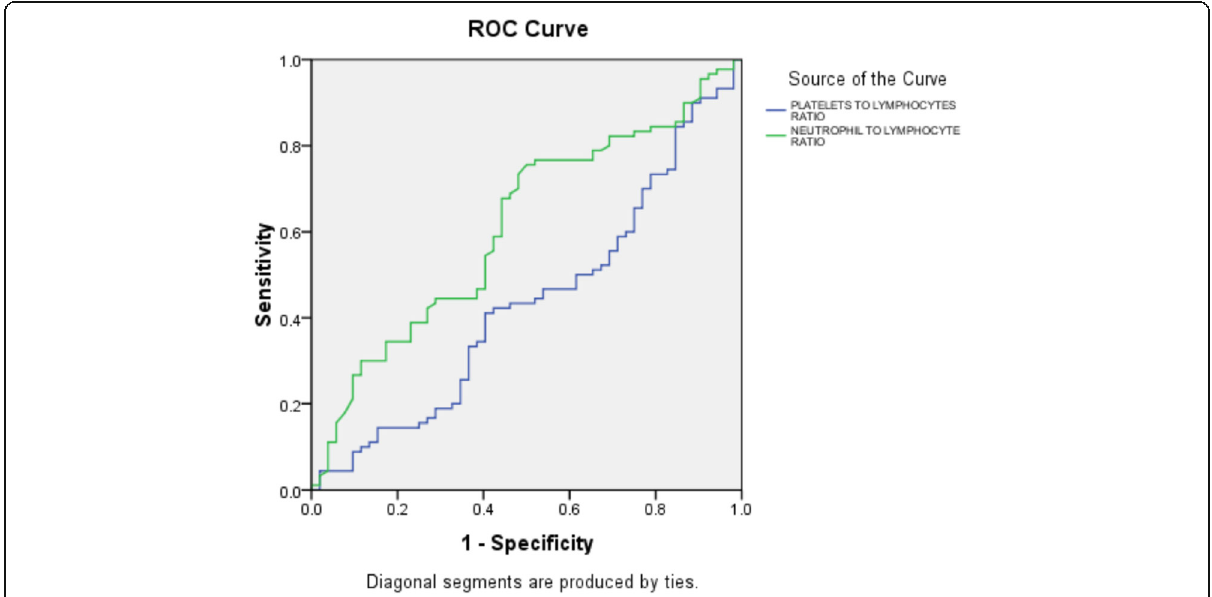
Fig. 2 ROC curve to detect embolization using the platelet-to-lymphocyte ratio and neutrophil-to-lymphocyte ratio